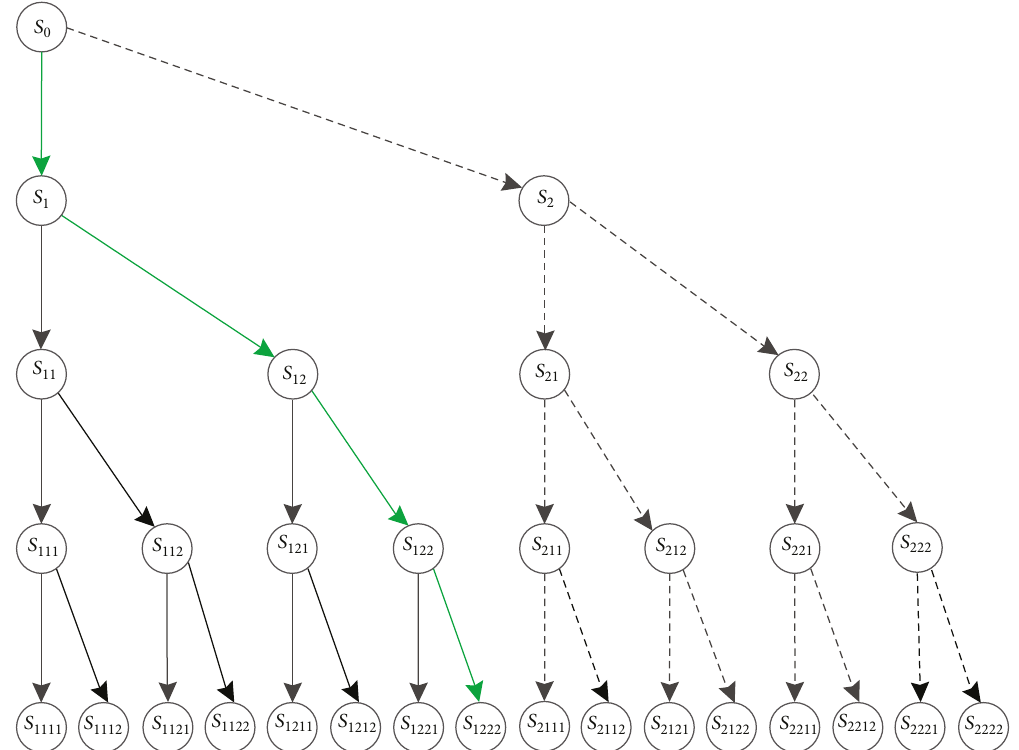
Figure 7: Tree-style structure for recursively searching series of static gaits.